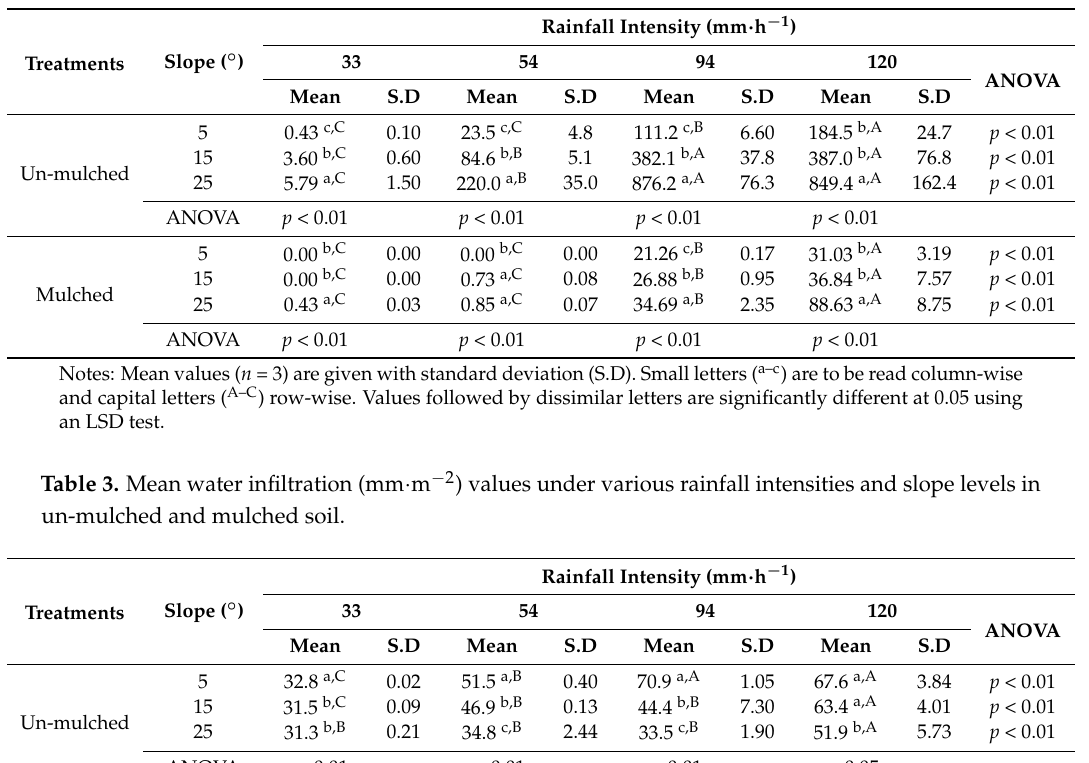
Table 2. Mean sediment loss (g · m − 2 ) values under various rainfall intensities and slope levels in un-mulched and mulched soil.